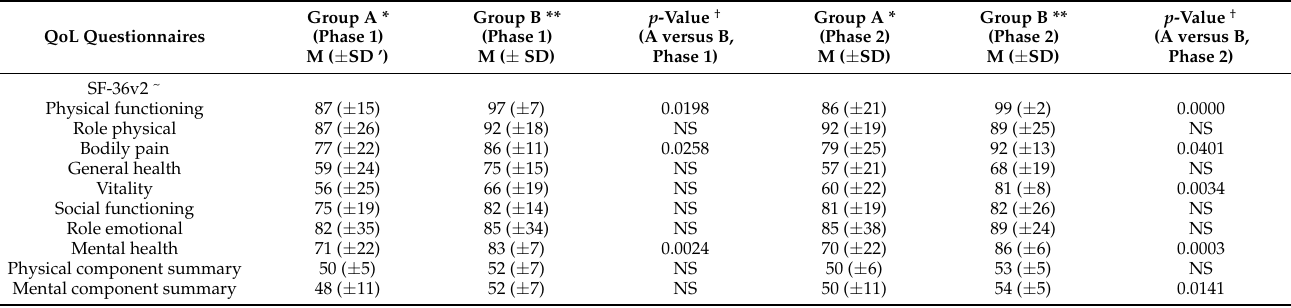
Table 4. Impact of interventional treatments on